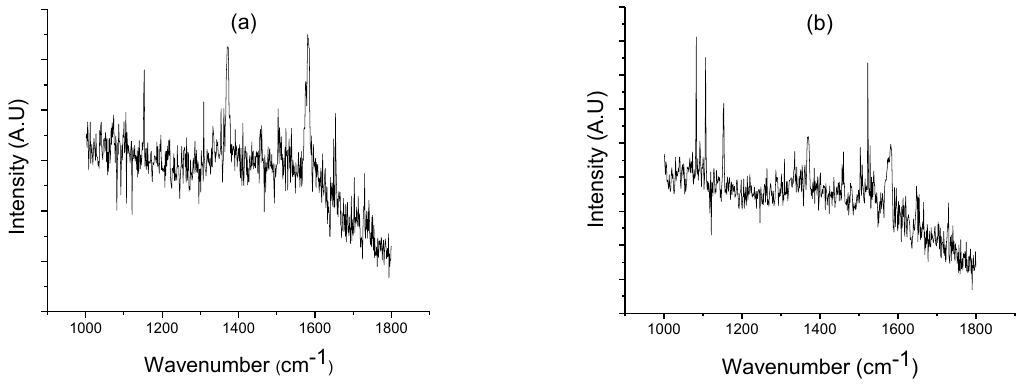
Figure 8. Raman pattern of decomposed siderite from processes, ( a ) mechanochemical ( b ), HTHP.